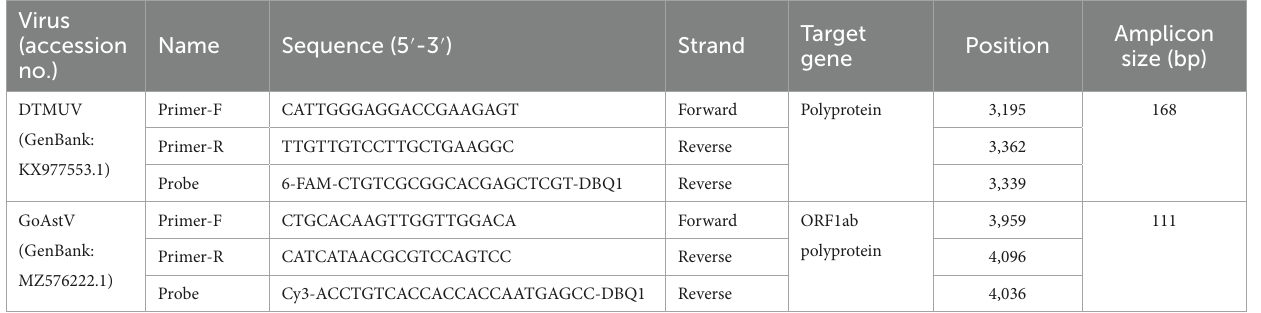
TABLE 1 Primers and probe used in this